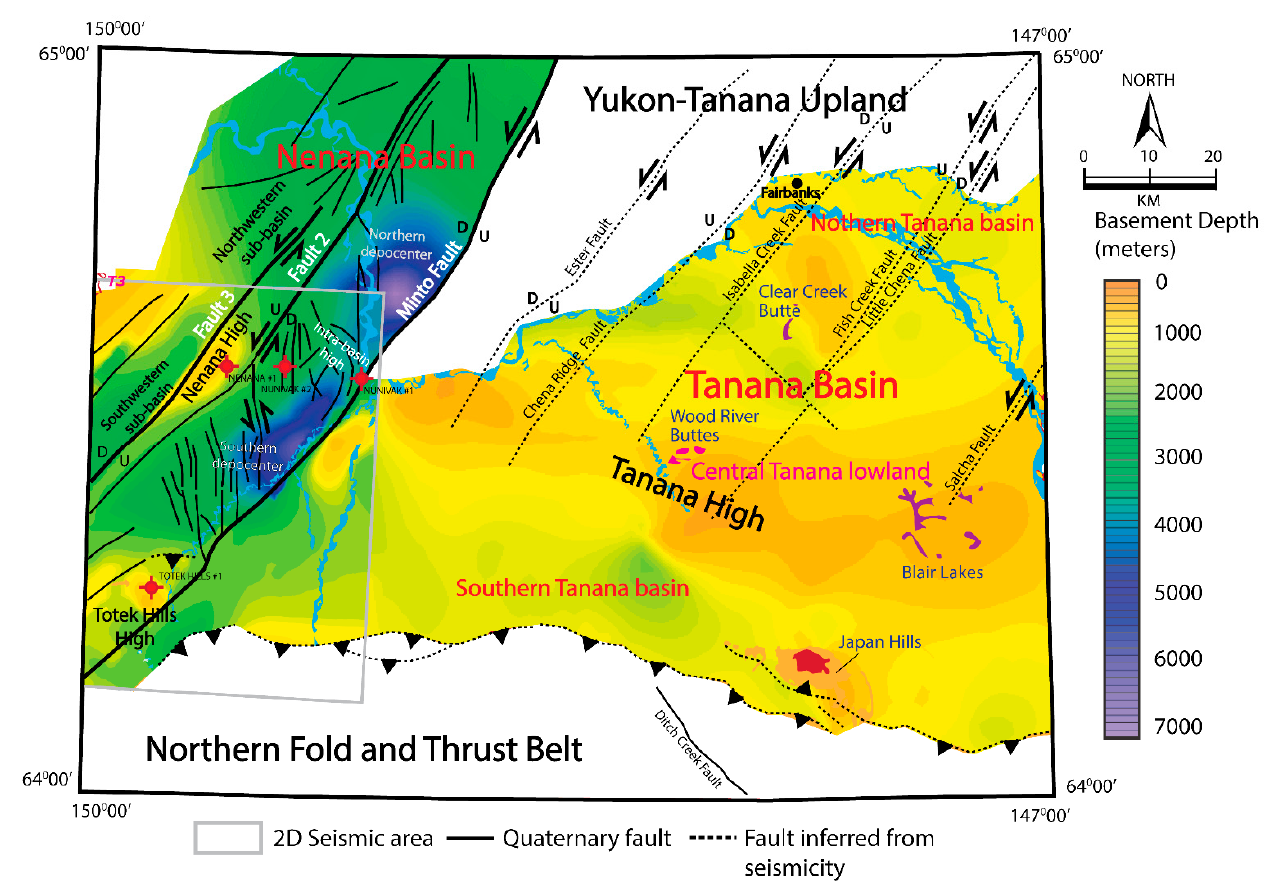
Figure 11. Basement depth map from integrated seismic and potential field models of both the Nenana and Tanana basins. While the composition of the crust underlying the two basins is similar, the distribution and thicknesses of the overlying sedimentary sequences vary greatly. Overall, the sedimentary fill in the Nenana basin is significantly thicker (up to 8 km) and probably older than that in the Tanana basin (up to 2 km thick).